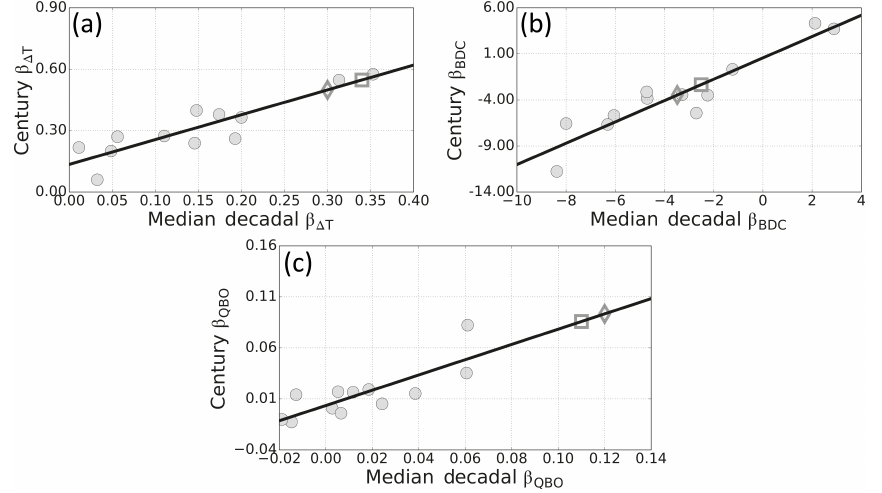
Figure 7. (a) Scatter plots of trended (cid:49)T regression coefficients (ppmvK − 1 ) vs. median decadal (cid:49)T regression coefficients (ppmvK − 1 ) from each CCM. (b) Same as (a) , but for BDC coefficients. (c) Same as (a) and (b) , but for QBO coefficient. Black lines in all plots correspond to a best-fit line between the trended and decadal coefficients, and the observational coefficients ERAI (square) and MERRA (diamond) are fitted to each line (from Dessler et al.,